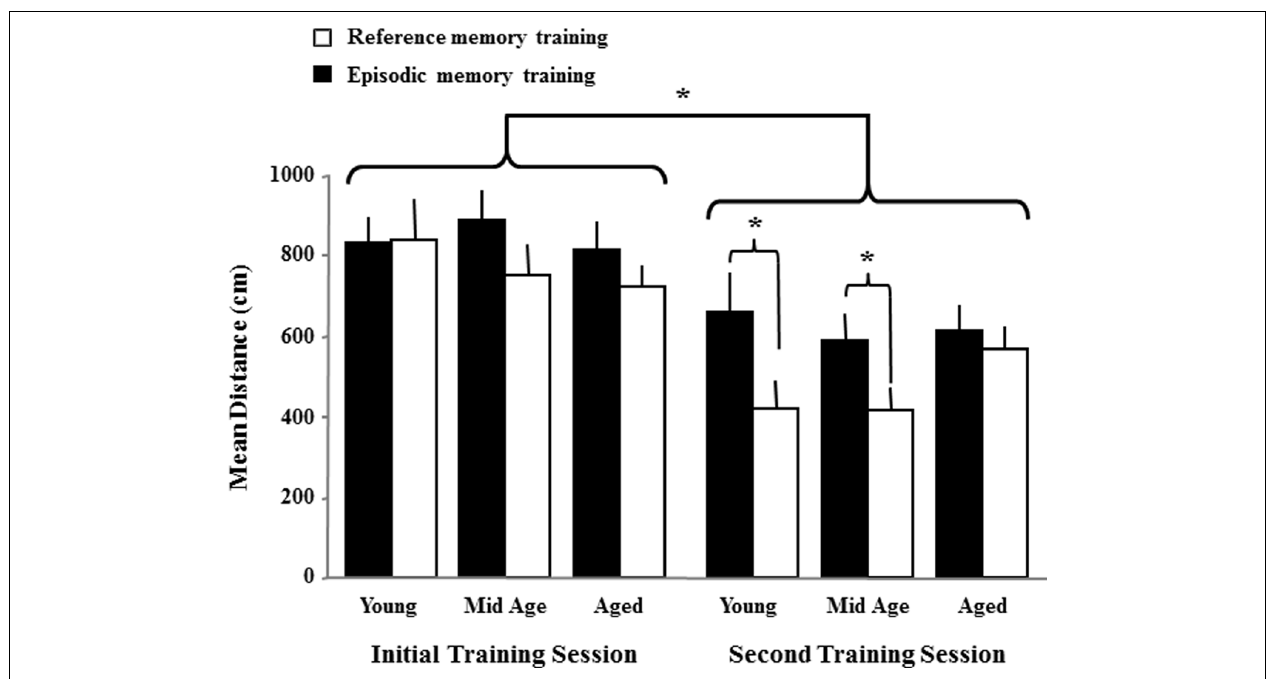
reduced escape distance when the platform was in the same location as the initial training session (reference memory training, open bars) relative to a new platform location (episodic memory training, filled bars). Asterisks indicate a significant difference ( p < 0.05) from the first to the second session across age and treatment groups and for location effects within each age group during the second session of